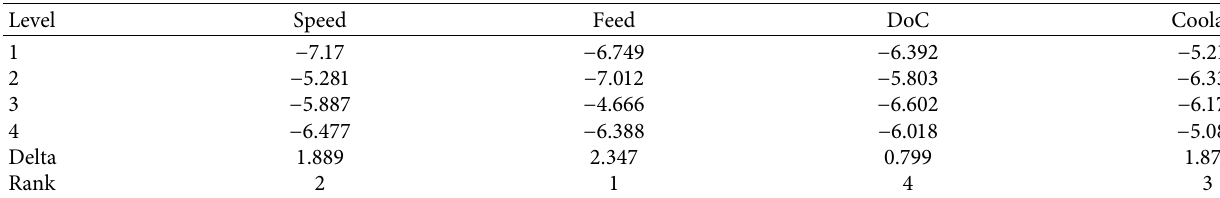
Table 8: S/N for TOPSIS.